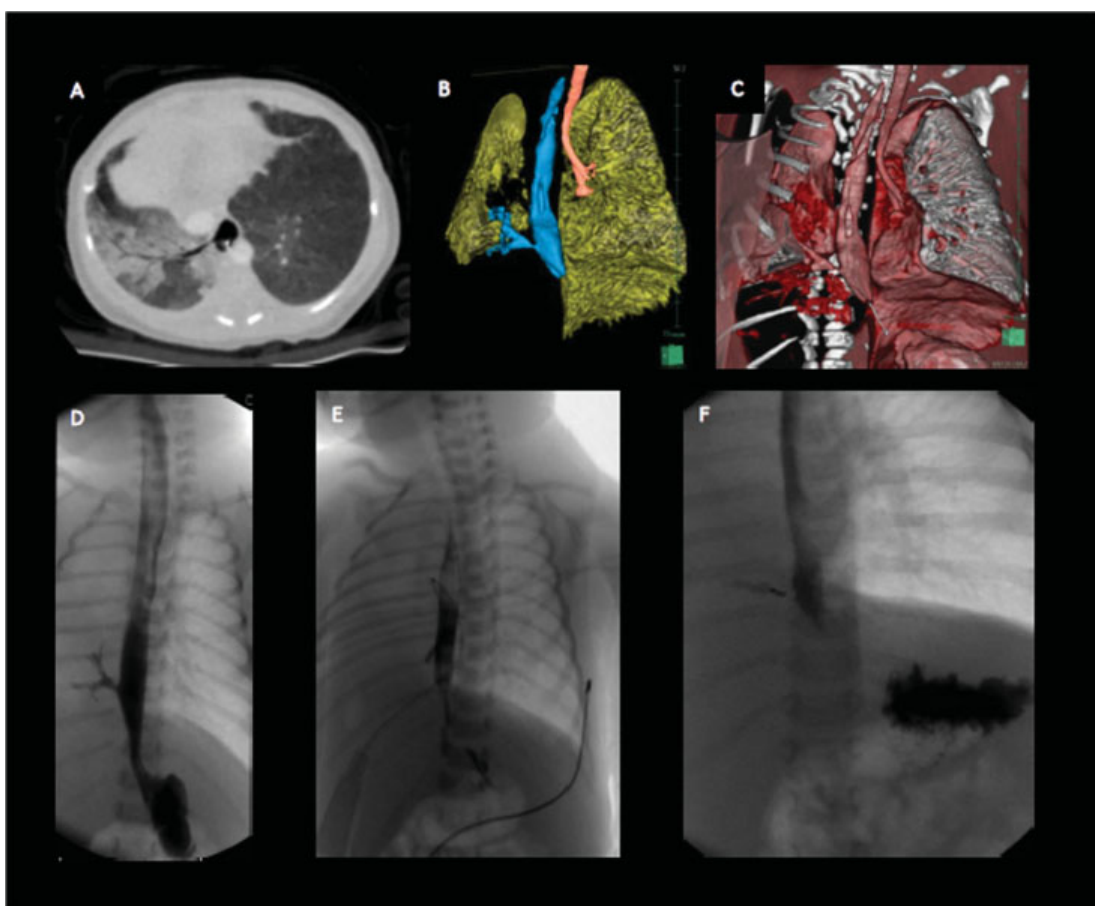
Fig. 1 Upper row: CTscan on day 3 of life. ( A ) Transverse section showing the anomalous origin of the right bronchus; ( B , C ) three-dimensional anatomy reconstruction showing the trachea ending with the left bronchus in the left lung and the right bronchus originating from the esophagus. Lower row: esophageal contrast studies ( D ) Esophageal contrast study on day 3 of life. The oral contrast evidences the anomalous origin of the right bronchus from the esophagus. ( E ) Contrast study on the 3 rd post-operative day after closure of the anomalous bronchus with clips. ( F ) Evidence of partial re-canalization of the anomalous bronchus at 5 months of age. CT, computed